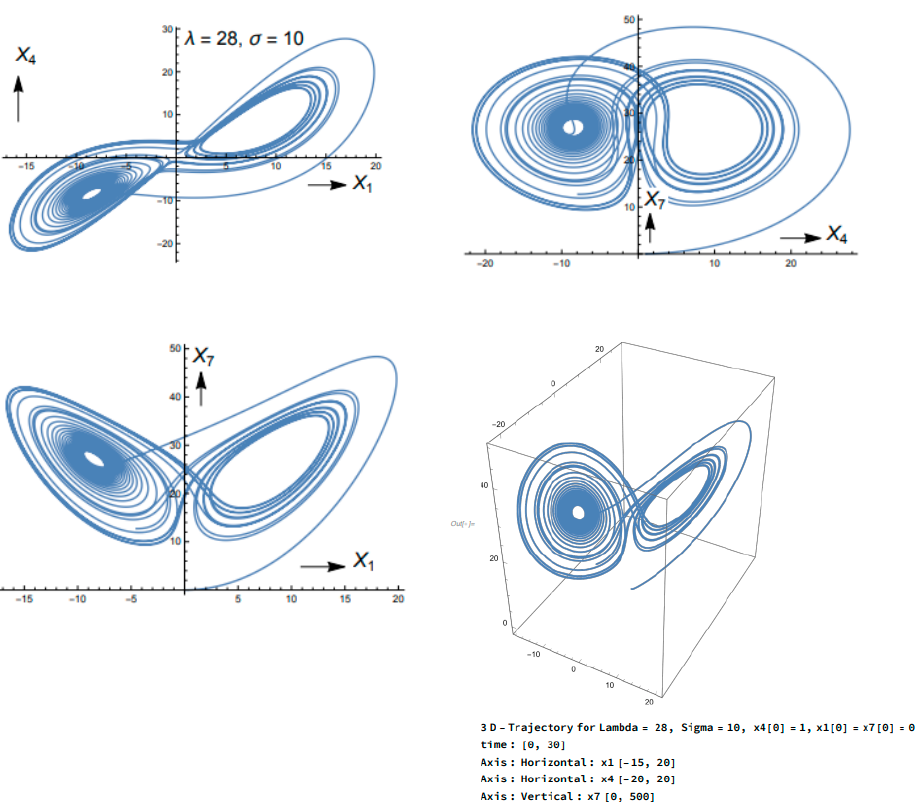
Figure 4. Phase plots of amplitudes for the chaotic regime with controls λ = 28, σ = 10.